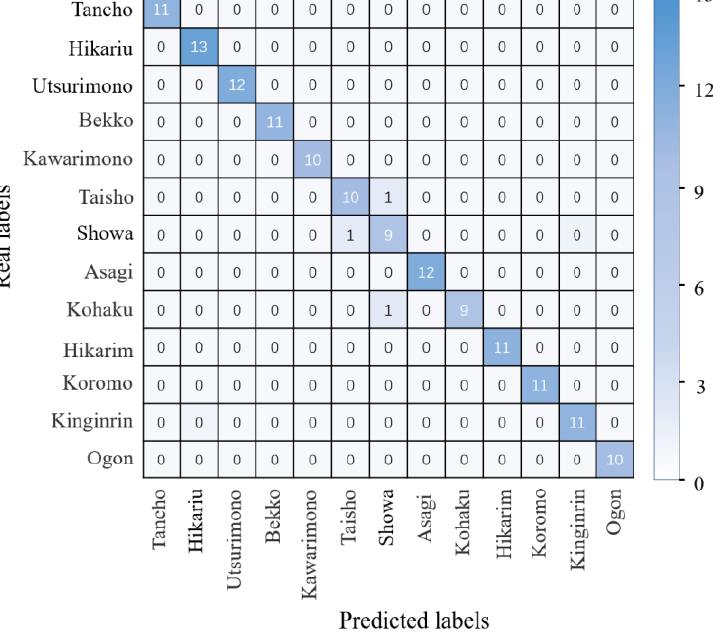
Figure 6. Confusion matrix.